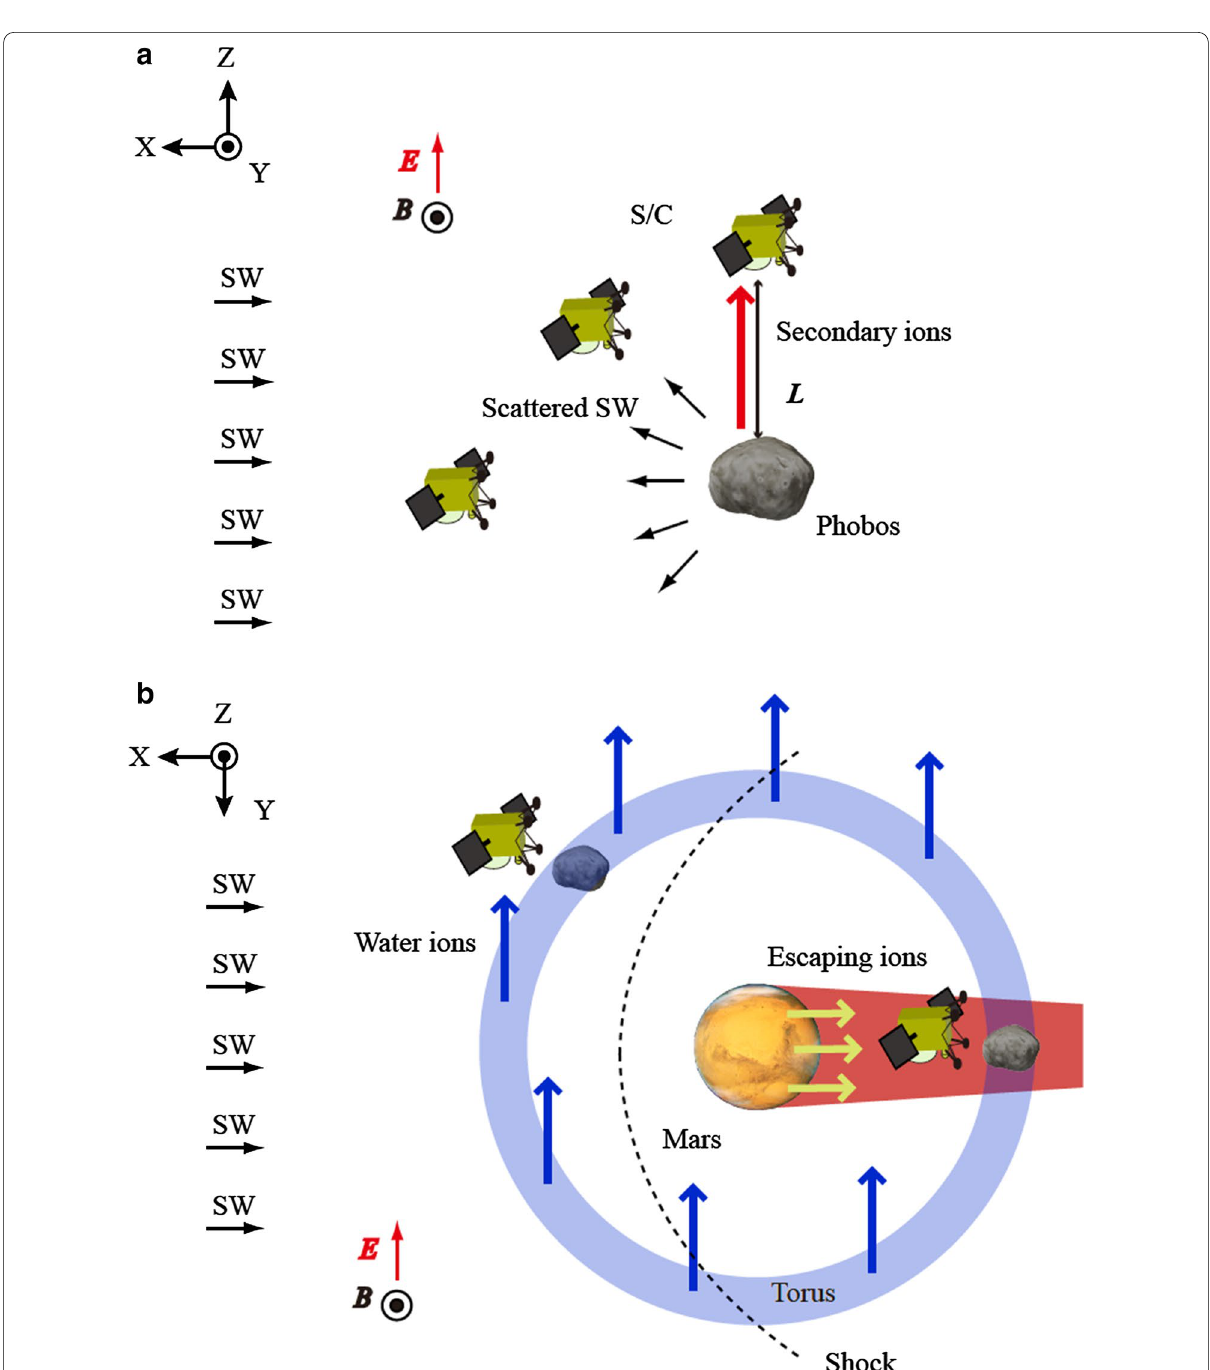
Fig. 5 Observation configurations of MSA. a MSA observations 1 and 3 for measuring solar wind (SW) ions, scattered SW ions on the Phobos surface, and secondary ions sputtered by the SW from Phobos surface. b MSA observations 2 and 4 for measuring water ions from the torus and escaping ions from the Martian atmosphere. In the both panels, B and E indicate the magnetic and electric fields of the SW, respectively. The magnetometer measures B , while E is derived from E = − V × B , where V denote the SW velocity measured by the ion analyzer. The Phobos/ Mars-centric Solar Ecliptic coordinate system is used in panels a and